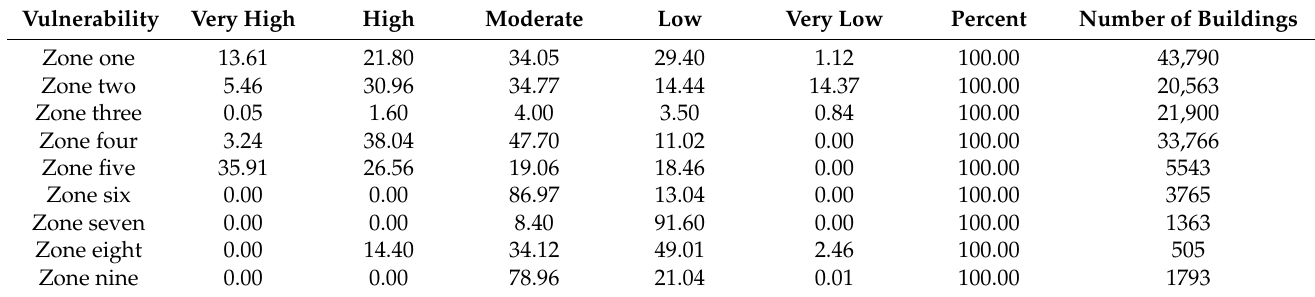
Table 6. Assessment of Residential Building Vulnerability (RBV) in Tabriz according SOM Method. Vulnerability